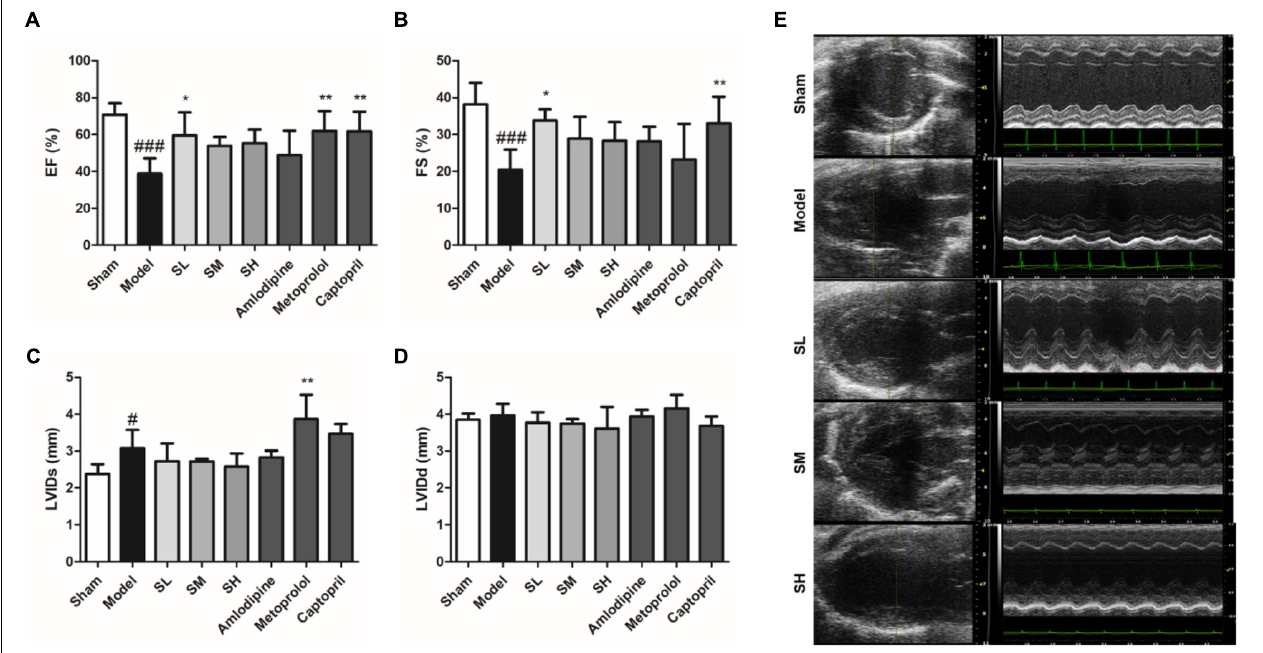
FIGURE 10 | The EF (A) , FS (B) , LVIDs (C) , and LVIDd (D) result of Schisandra treated AMI mice. (E) The Ultrasonic Cardiogram of Schisandra treated mice was tested 30 min after the last corresponding drugs were given. All data are shown as the mean ± SD. # P < 0.05, ### P < 0.001 vs. Sham group; ∗ P < 0.05, ∗∗ P < 0.01 vs. Model